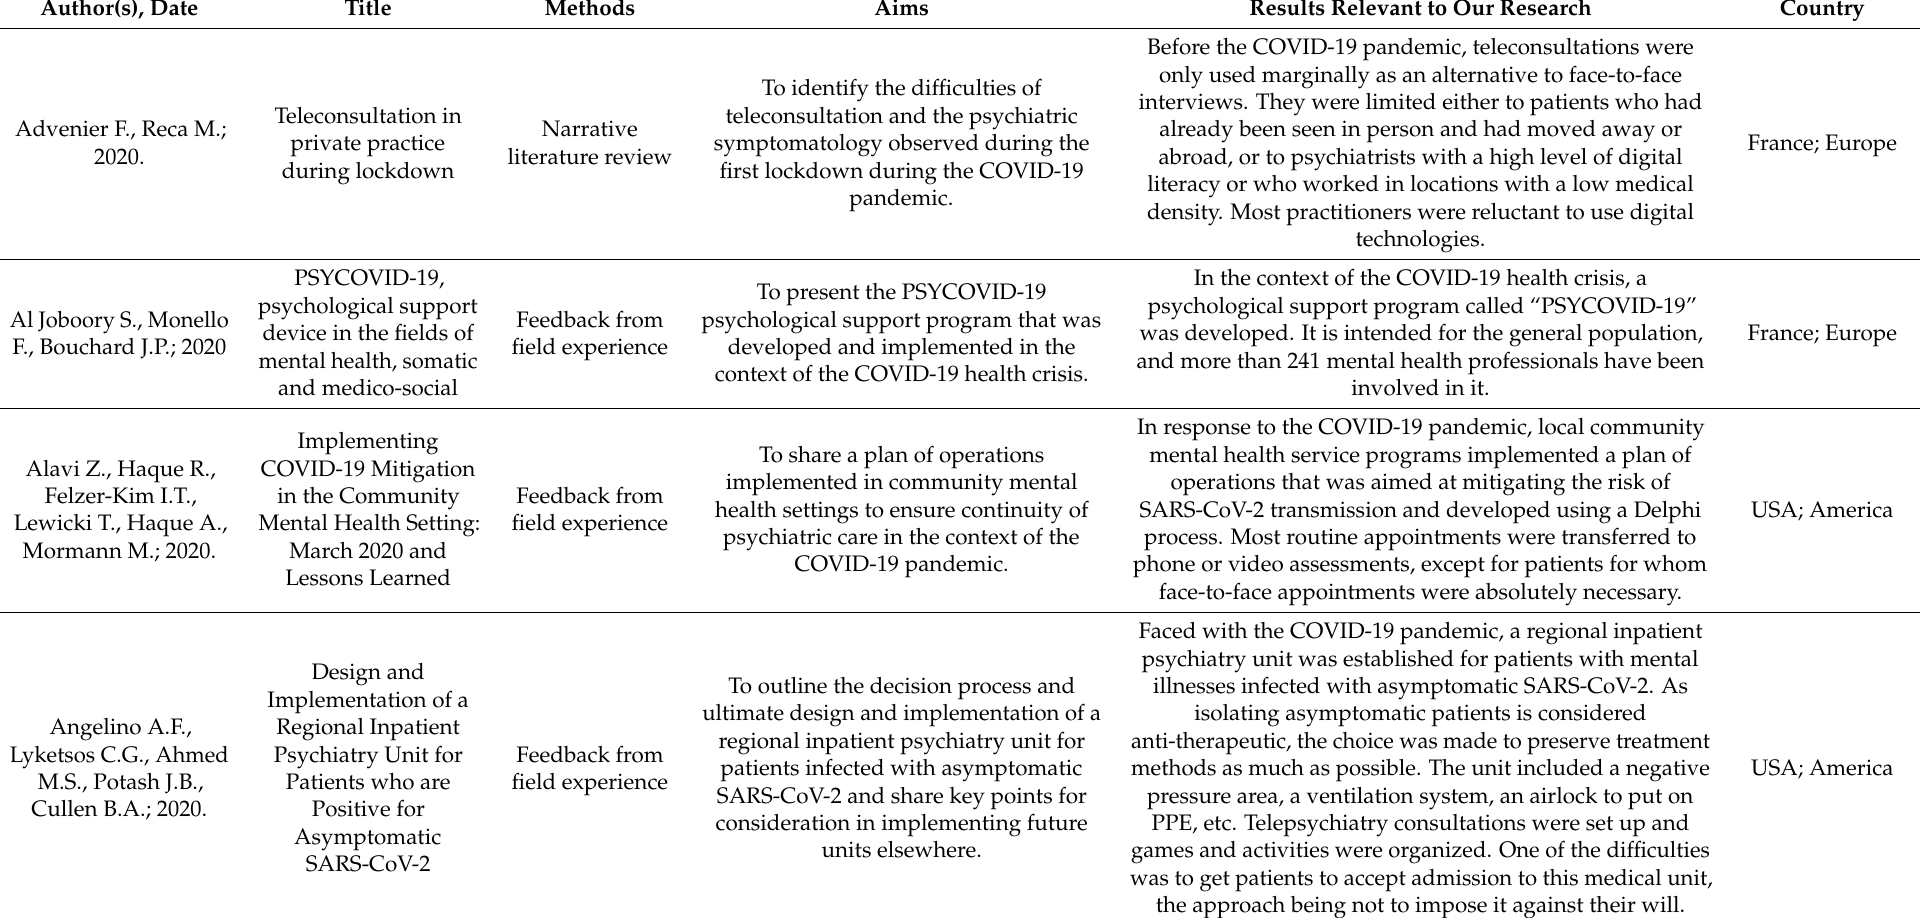
Table 2. Overview of the articles